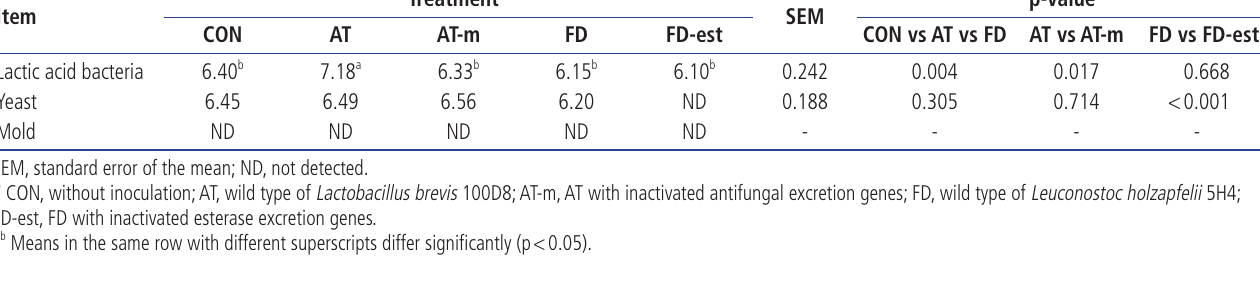
Table 4. Effects of wild and mutated inoculants on microbial counts of rye silage ensiled for 90 d (log10 cfu/g) Item